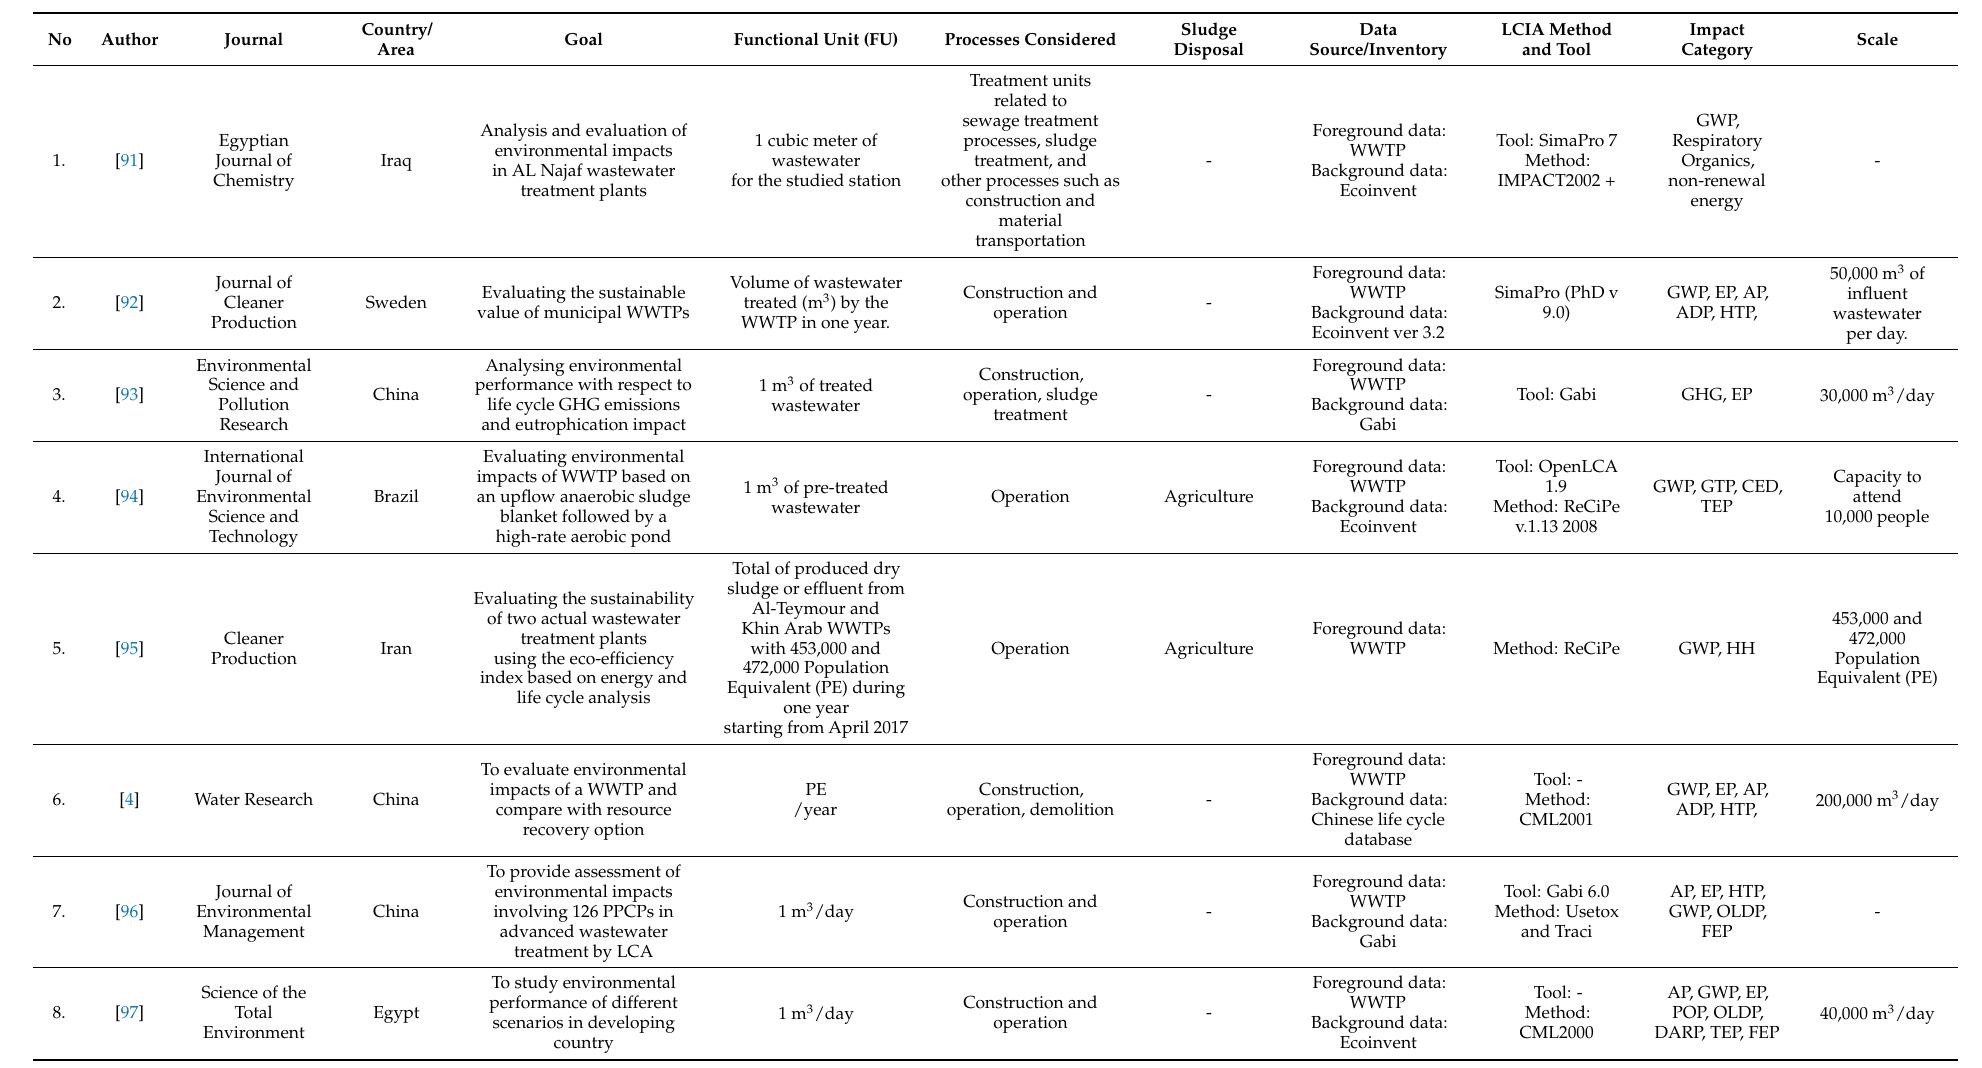
Table 3. Overview of existing study of LCA in wastewater management from 2006 to